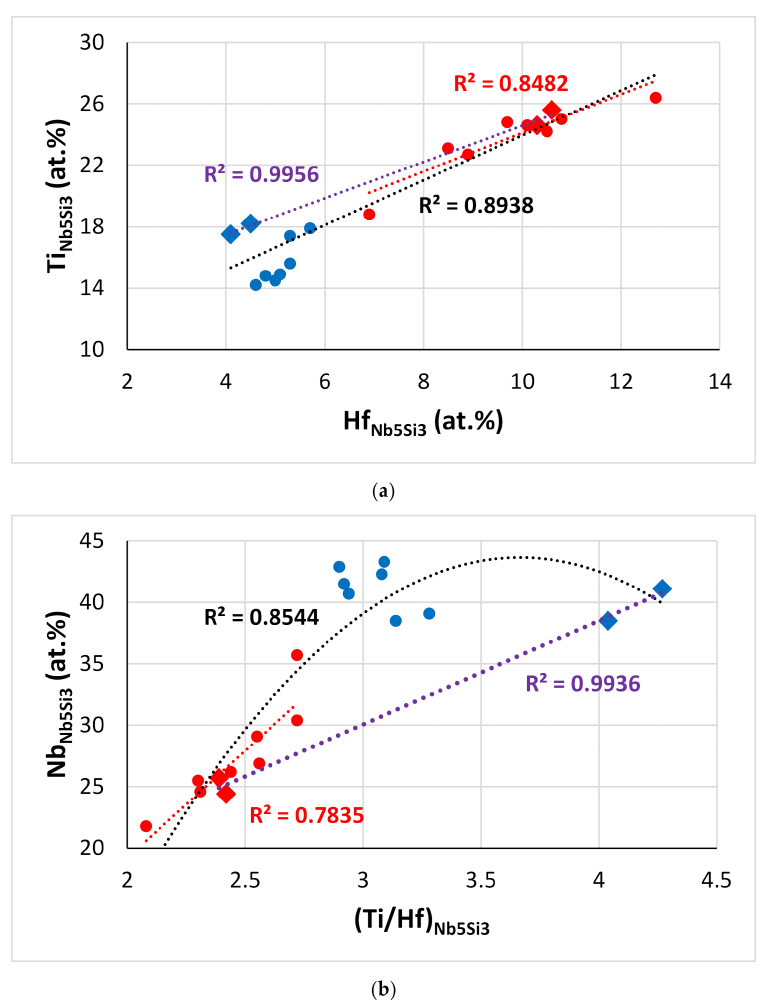
Figure 13. ( a ) The Ti versus Hf map and ( b ) the Nb versus Ti/Hf map for the Nb 5 Si 3 in the al- loys of this work. Blue data for “normal” Nb 5 Si 3 , red data for Hf-rich Nb 5 Si 3 . Diamonds for the RM(Nb)IC/RCCA alloy EZ8. In ( a , b ), the data for EZ8 have, respectively, R 2 = 0.9956 and R 2 = 0.9936. For all data in ( a , b ), the R 2 value is 0.8938 and 0.8544,